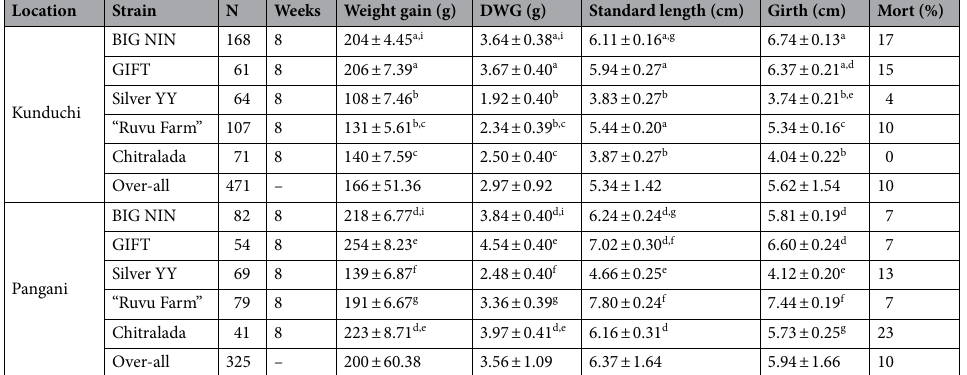
Table 3. Mean body weight gain, standard length, girth and mortality percentages of grow-out in hapas of five Nile tilapia strains reared at Kunduchi and Pangani. Means of different strains within a location and the same strain between locations followed by different superscripts in the same column significantly differ (p < 0.05) by the F-test. N = number of samples, S = % survival rate.